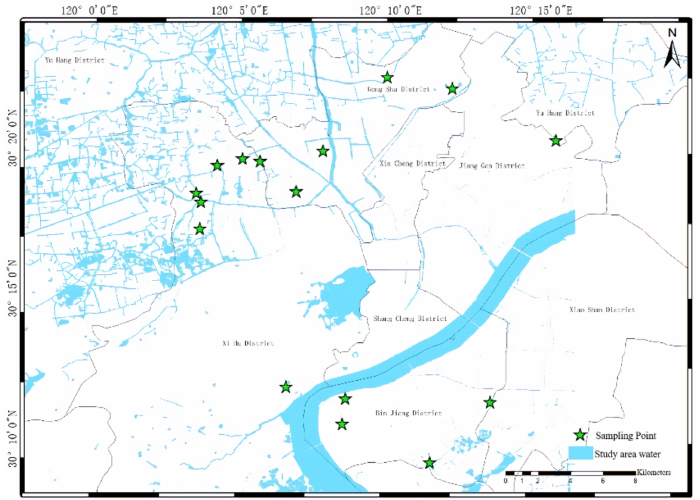
Figure 1. Measured water points